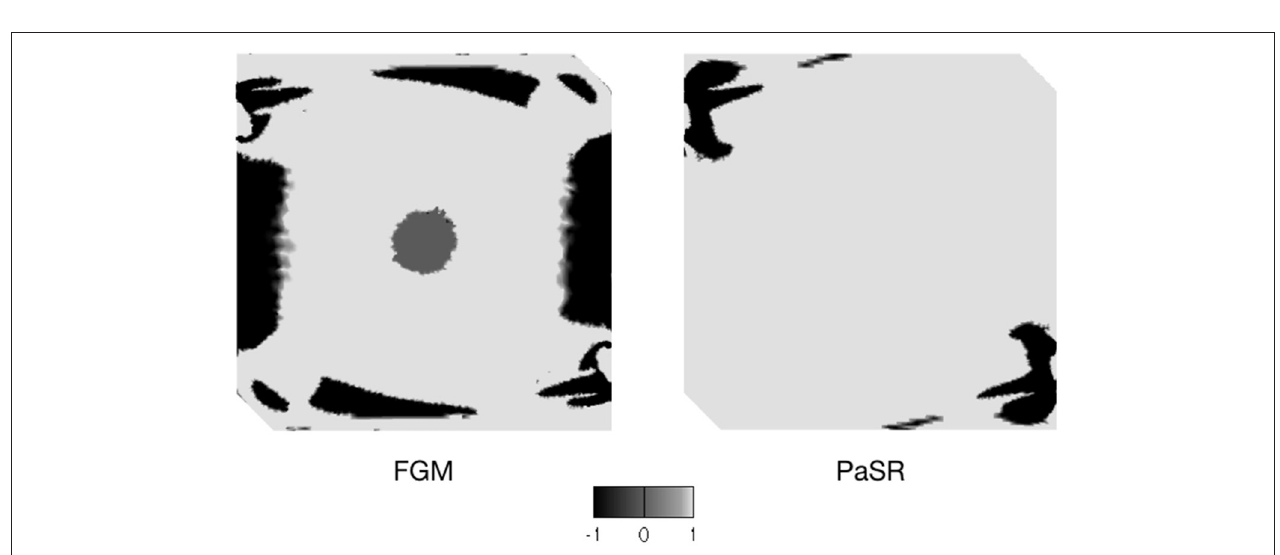
FIGURE 5 | Case 1 flame index contours for FGM and PaSR static